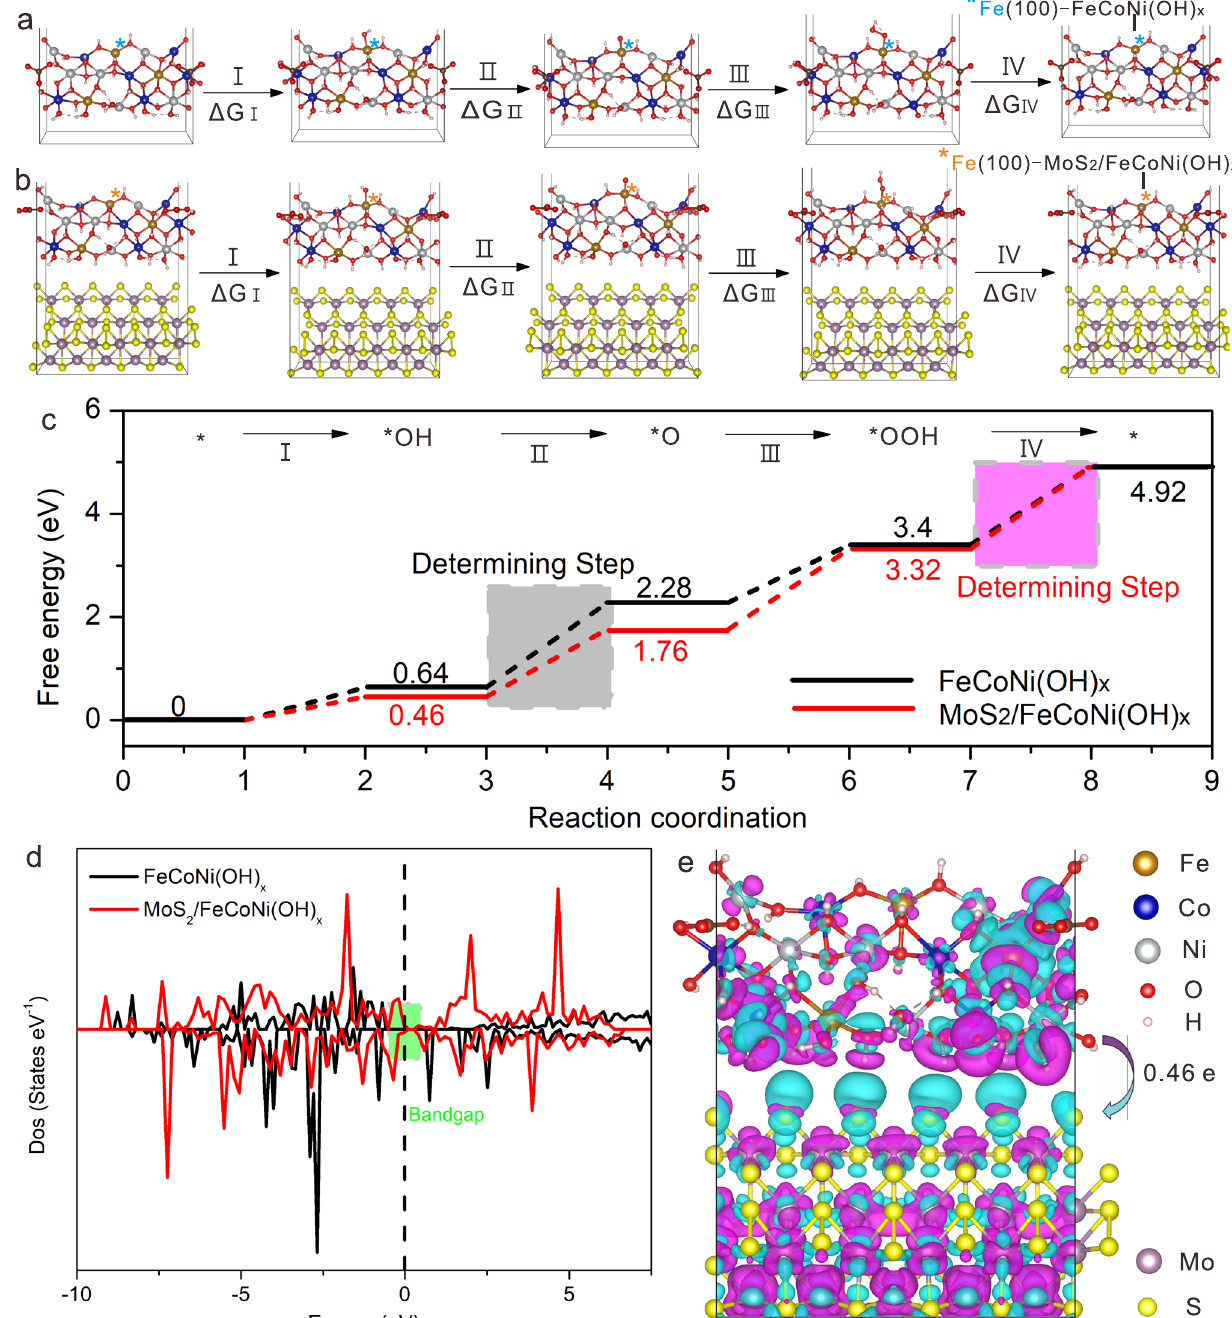
Fig. 6 Theoretical calculations of the electrocatalysts. a Proposed 4e - mechanism of OER on FeCoNi(OH) x (see panel e to distinguish different atoms). b Proposed 4e - mechanism of OER on MoS 2 /FeCoNi(OH) x (see panel e to distinguish different atoms). c Gibbs free energy diagram for the four steps of OER on FeCoNi(OH)x and MoS 2 /FeCoNi(OH) x at the position of Fe ions. d Total density of states curves of FeCoNi(OH) x and MoS 2 /FeCoNi(OH) x . e Differential charge density between FeCoNi(OH) x and MoS 2 . The Fe ion (*) in a , b is the active